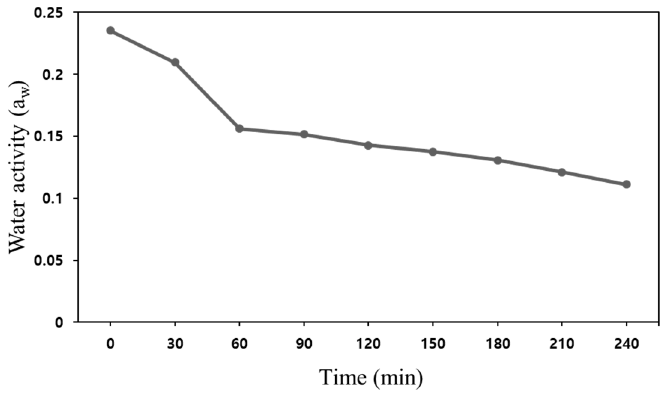
Figure 15. Change in water activity at vacuum heating time (0 to 240 min).